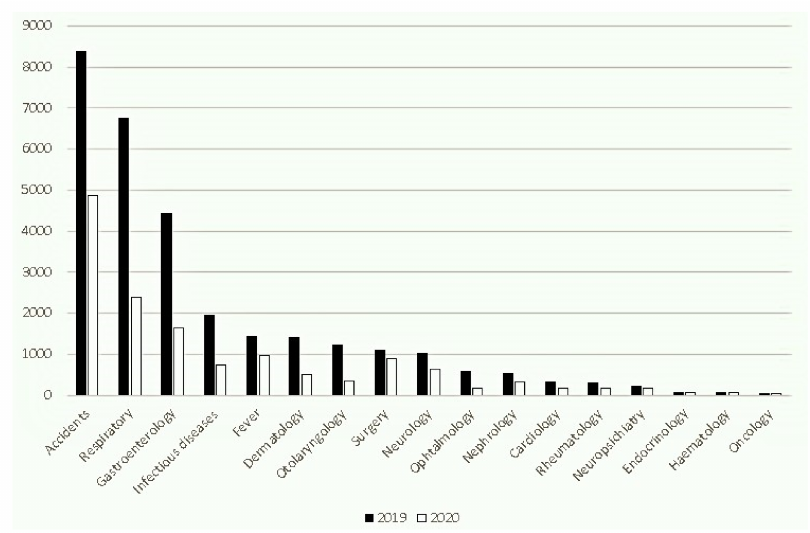
Figure 2. Pediatric ER diagnoses in September–November, 2019 and